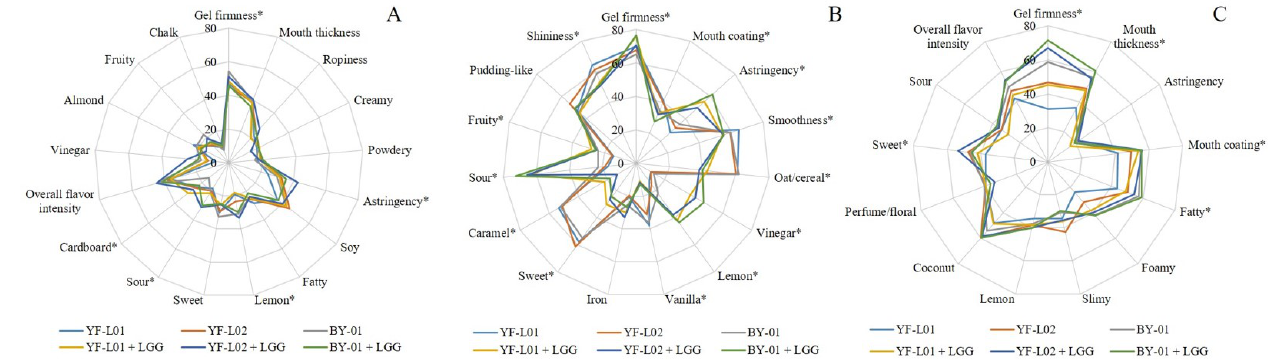
Figure 3. Perception of sensory attributes in ( A ) soy, ( B ) oat, and ( C ) coconut samples fermented with different culture